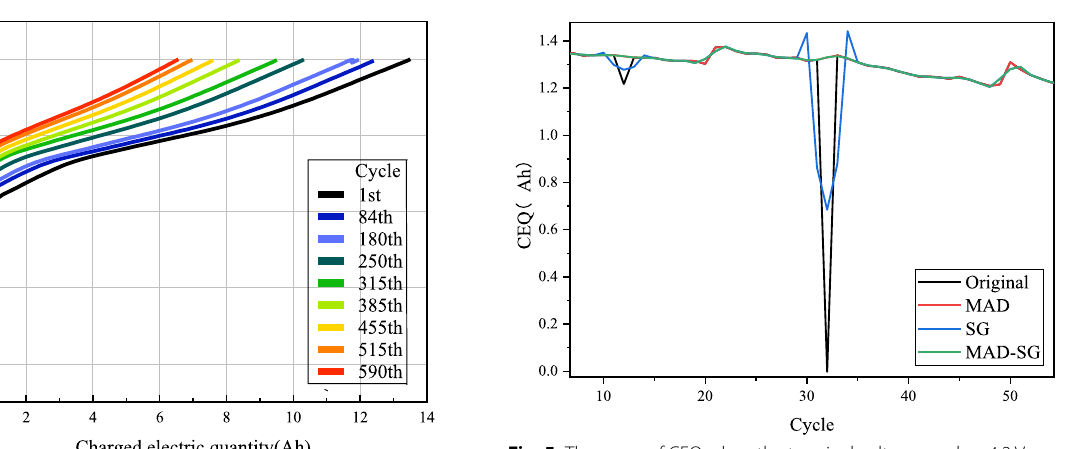
Fig. 5 The curve of CEQ when the terminal voltage reaches 4.2 V after processing the data with different filtering